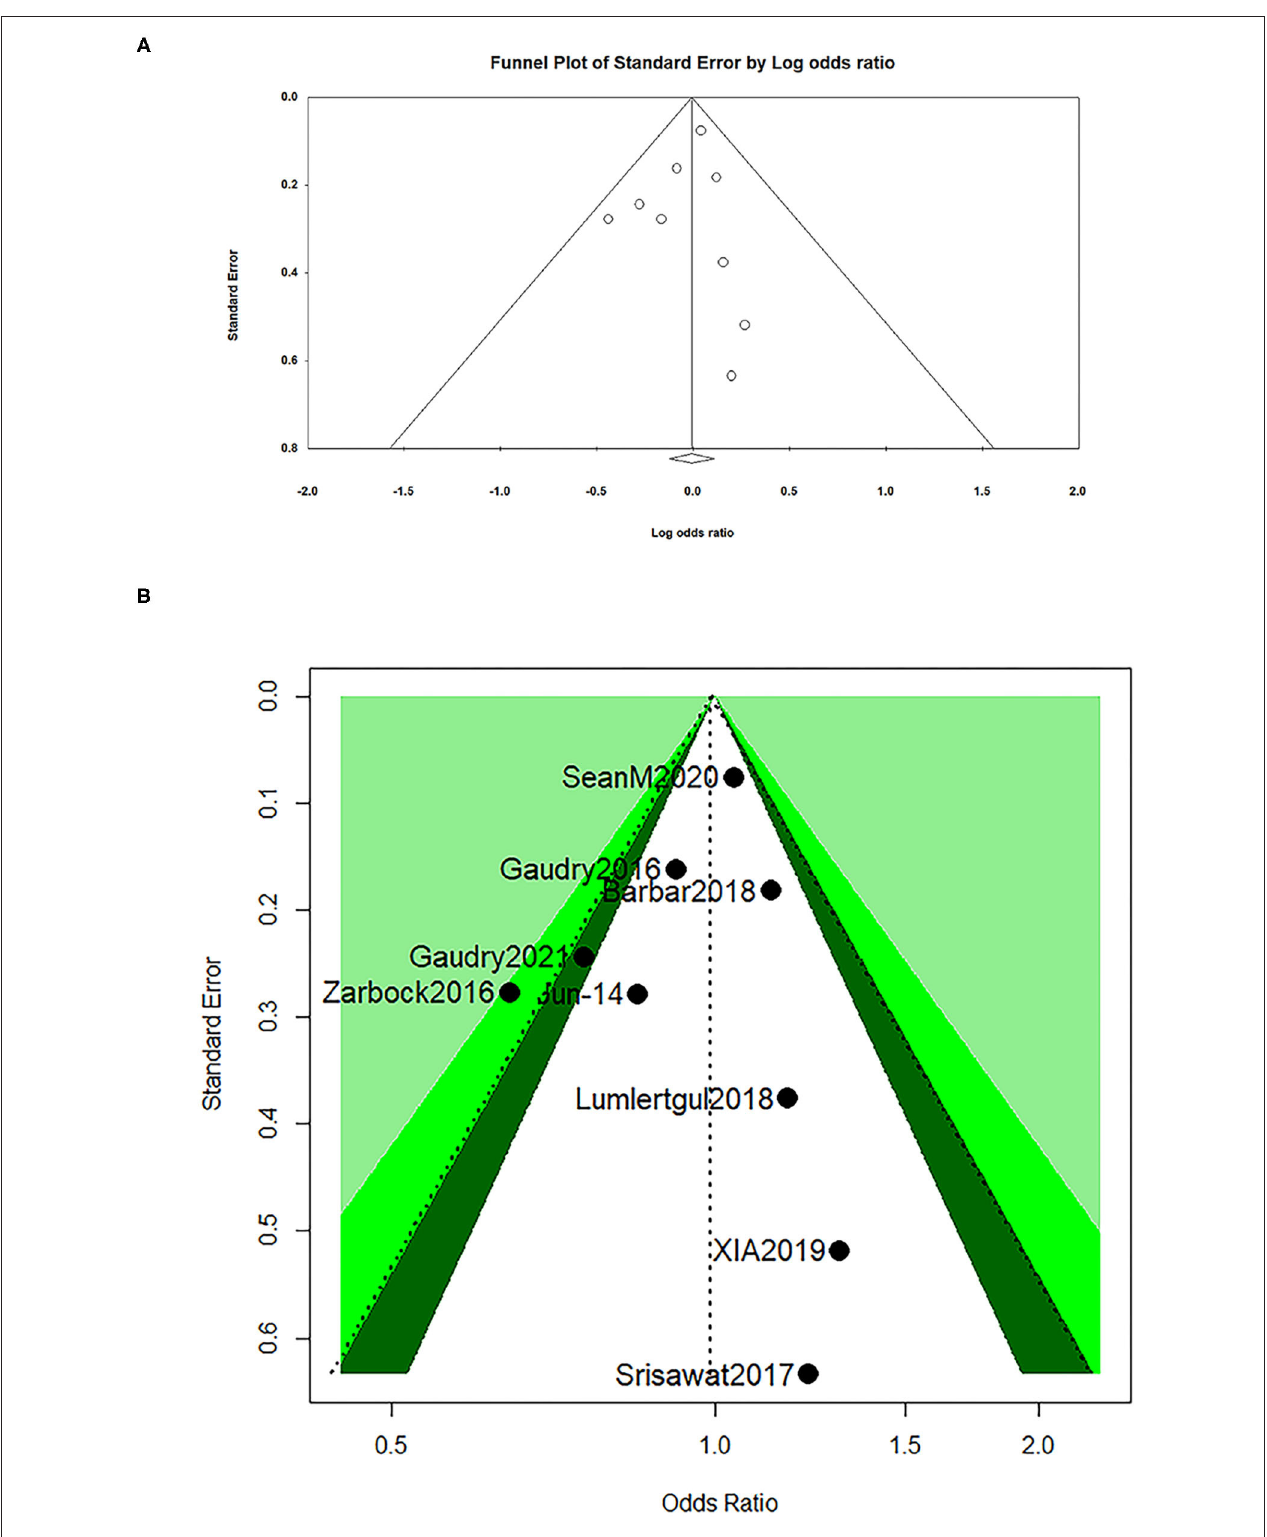
FIGURE 4 | Funnel plot for all-cause mortality at day 28 (A) and contour-enhanced funnel for all-cause mortality at day 28 (B) .